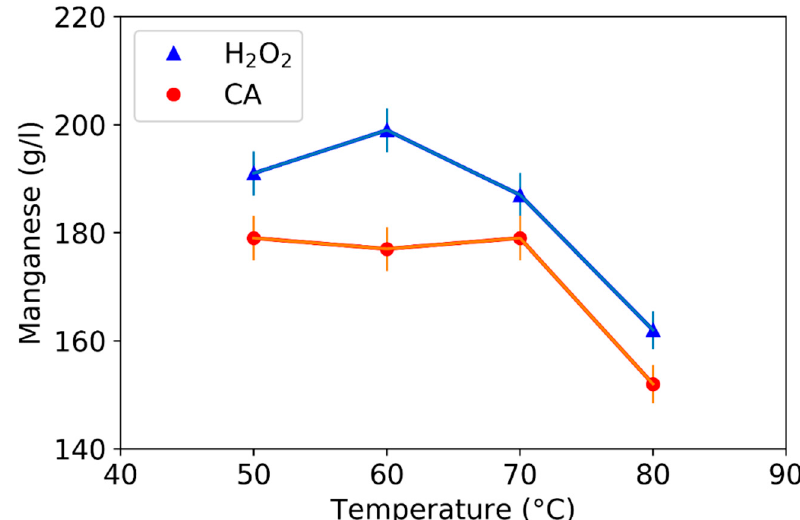
Figure 6. Comparison of reducing agents on manganese concentration at different temperatures after 180 min of reaction time using S/L 420.